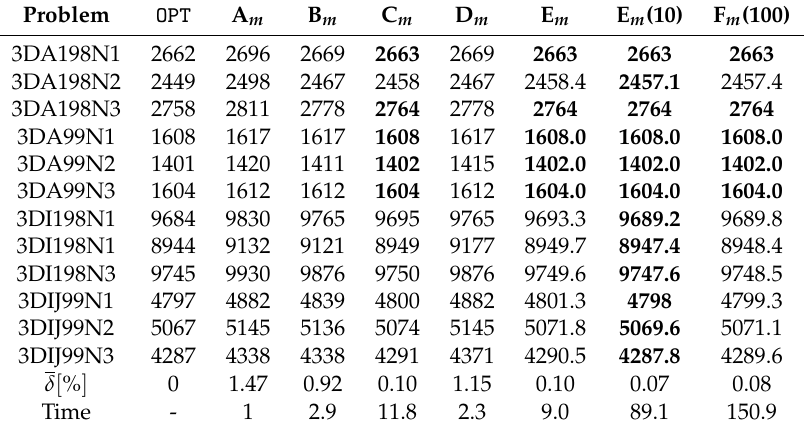
Table 3. Comparison of Algorithms A m , B m , C m , D m , E m , E m (10), and F m (100) on the first group of instances of 3-AP from [15,30]. Column 2 contains the optimum value of the problem, as reported